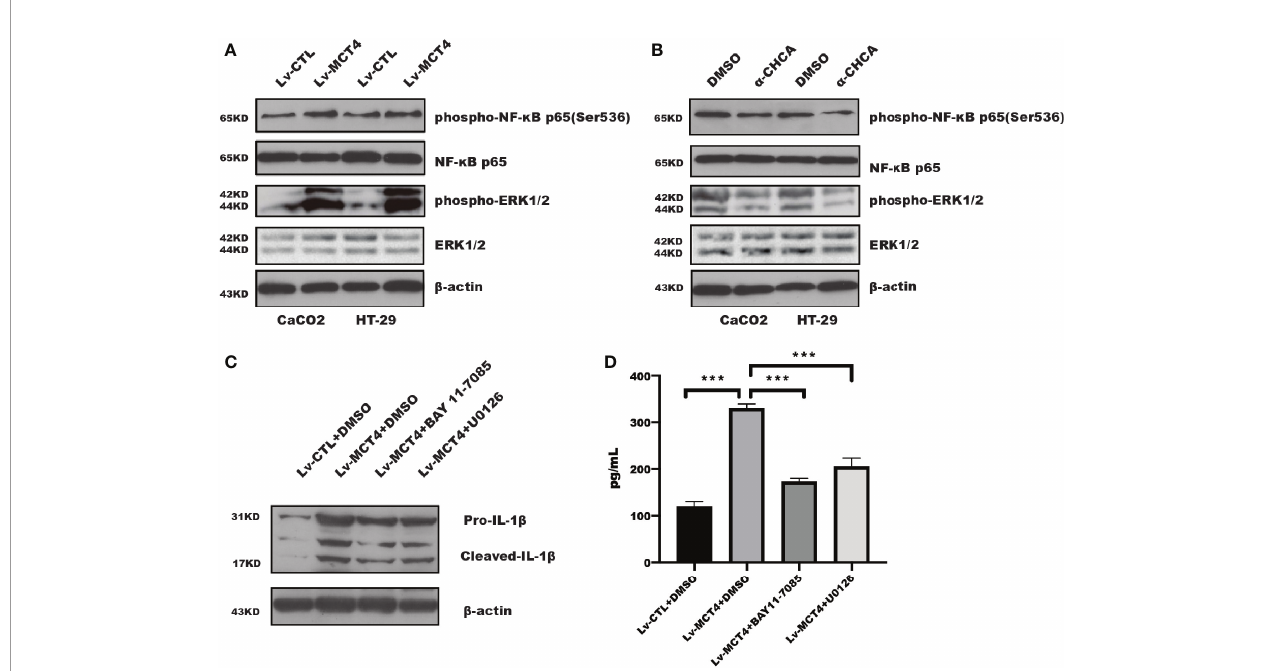
FIGURE 3 | MCT4 regulated ERK1/2-NF- k B pathway. (A) Western blotting was employed to test phosphorylation of NF- k B and ERK1/2 activity in HT-29 and CaCO2 cells. (B) The total protein was collected in HT-29 and CaCO2 cells with or without a -CHCA stimulation for 1 h, and the indicated proteins was tested by immunoblotting. The ERK1/2 inhibitor U0126 and NF- k B inhibitor BAY11-7085 were used to treat CaCO2 cells with MCT4 overexpression for 48 h. Western blotting (C) and ELISA (D) were used to analyze IL-1 b expression and secretion, respectively. Data represented the mean ± s.d. of three independent experiments; one-way ANOVA was performed to analyze statistical difference. *** p <